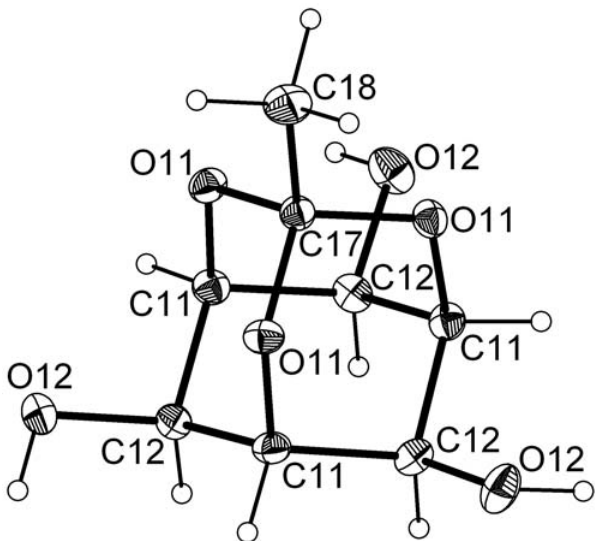
Table 1. Data collection and handling.